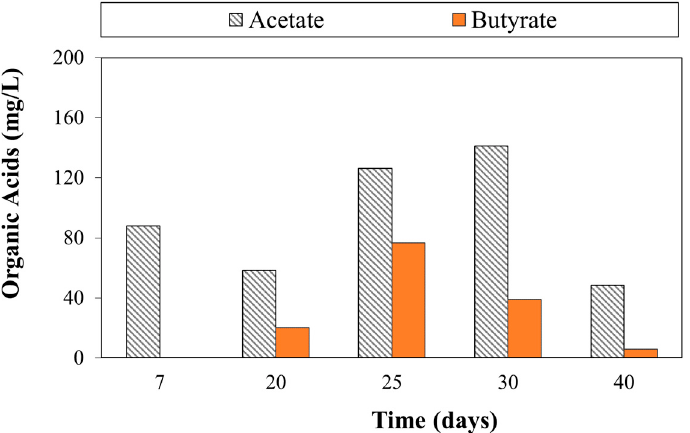
Figure 9. Organic acids concentration in the effluent at different operation days.